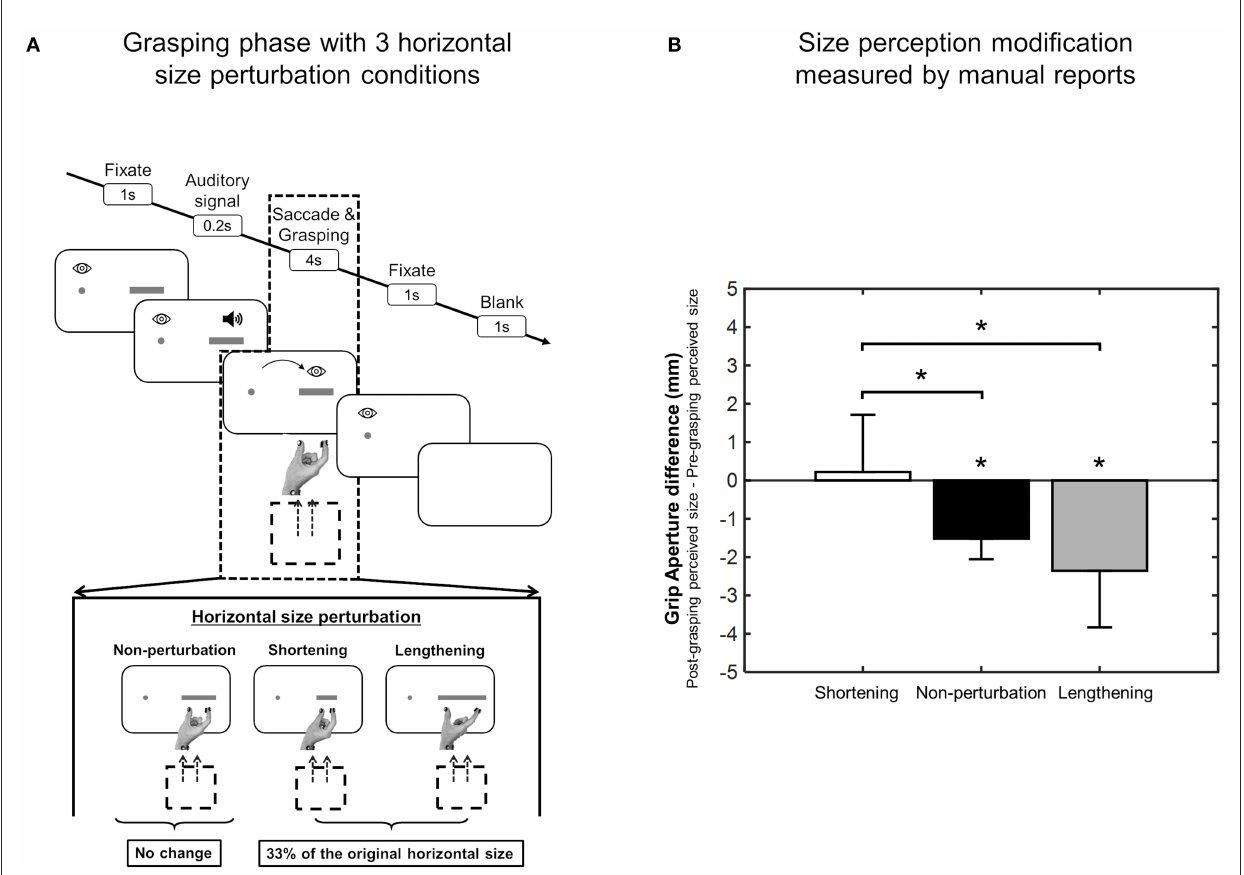
FIGURE7 Size perception modification after size-perturbed grasping execution. (A) Experimental task sequence. (B) Mean Deviation values of grip aperture from the baseline averaged across size perturbation condition. Details as in Figure 5 (modified from Sanz Diez et al., 2022). * p < 0.05, significance